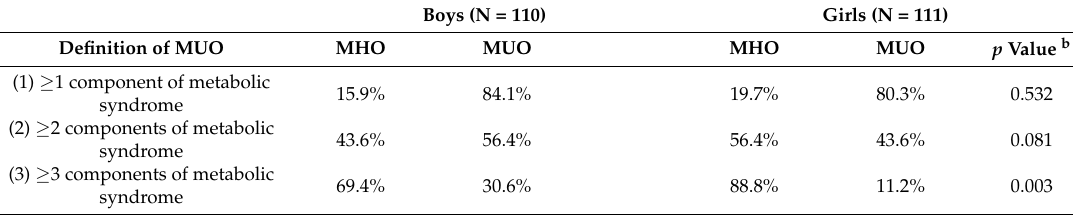
Table 1. Prevalence, characteristics, and body composition of